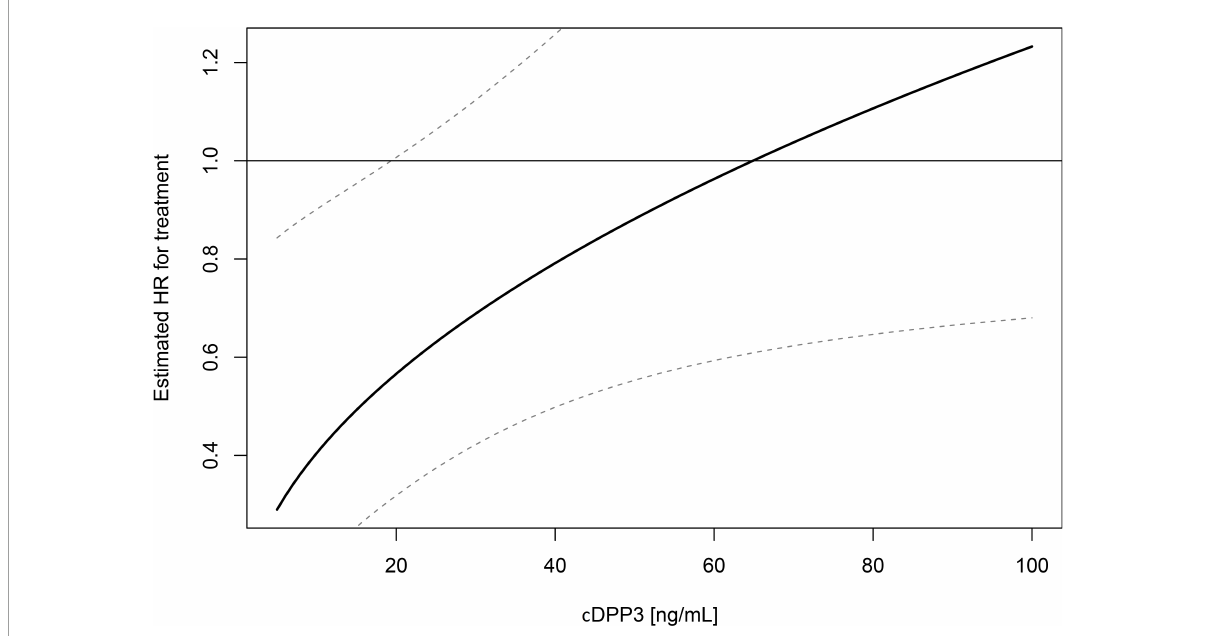
FIGURE2 Hazard ratio (HR) of Adrecizumab treatment varying on circulating dipeptidyl peptidase 3 (cDPP3) level. Reported results are from an interaction analysis between Adrecizumab treatment and baseline cDPP3 concentration, i.e., a Cox regression was performed that included cDPP3, treatment status and the interaction term. HR and associated 95% CI compared to the placebo group are